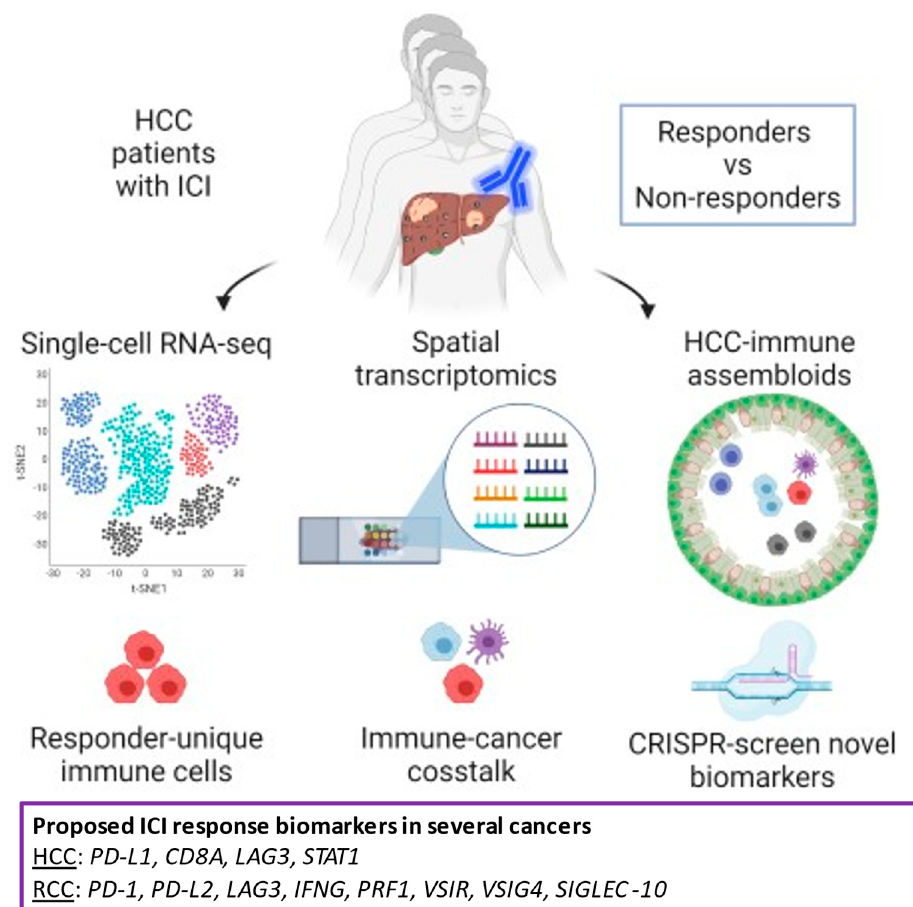
Figure 7. Potential biomarkers of ICI response and the future platform of translational research. Hepatocellular carcinoma (HCC) patients undergo immune checkpoint inhibitor (ICI) treatment. The patients will be divided in responders and non-responders according to clinical response. Single-cell RNA-seq of patient’s tumor samples will identify responder-unique immune cells. Spatial transcriptomics will define immune-cancer crosstalk. HCC-immune assembloids will provide experimental platforms to determine novel biomarkers such as CRISPR-based genetic screening. The high expression of inflammatory genes is proposed as potential biomarkers in HCC, renal cell carcinoma (RCC), and melanoma.